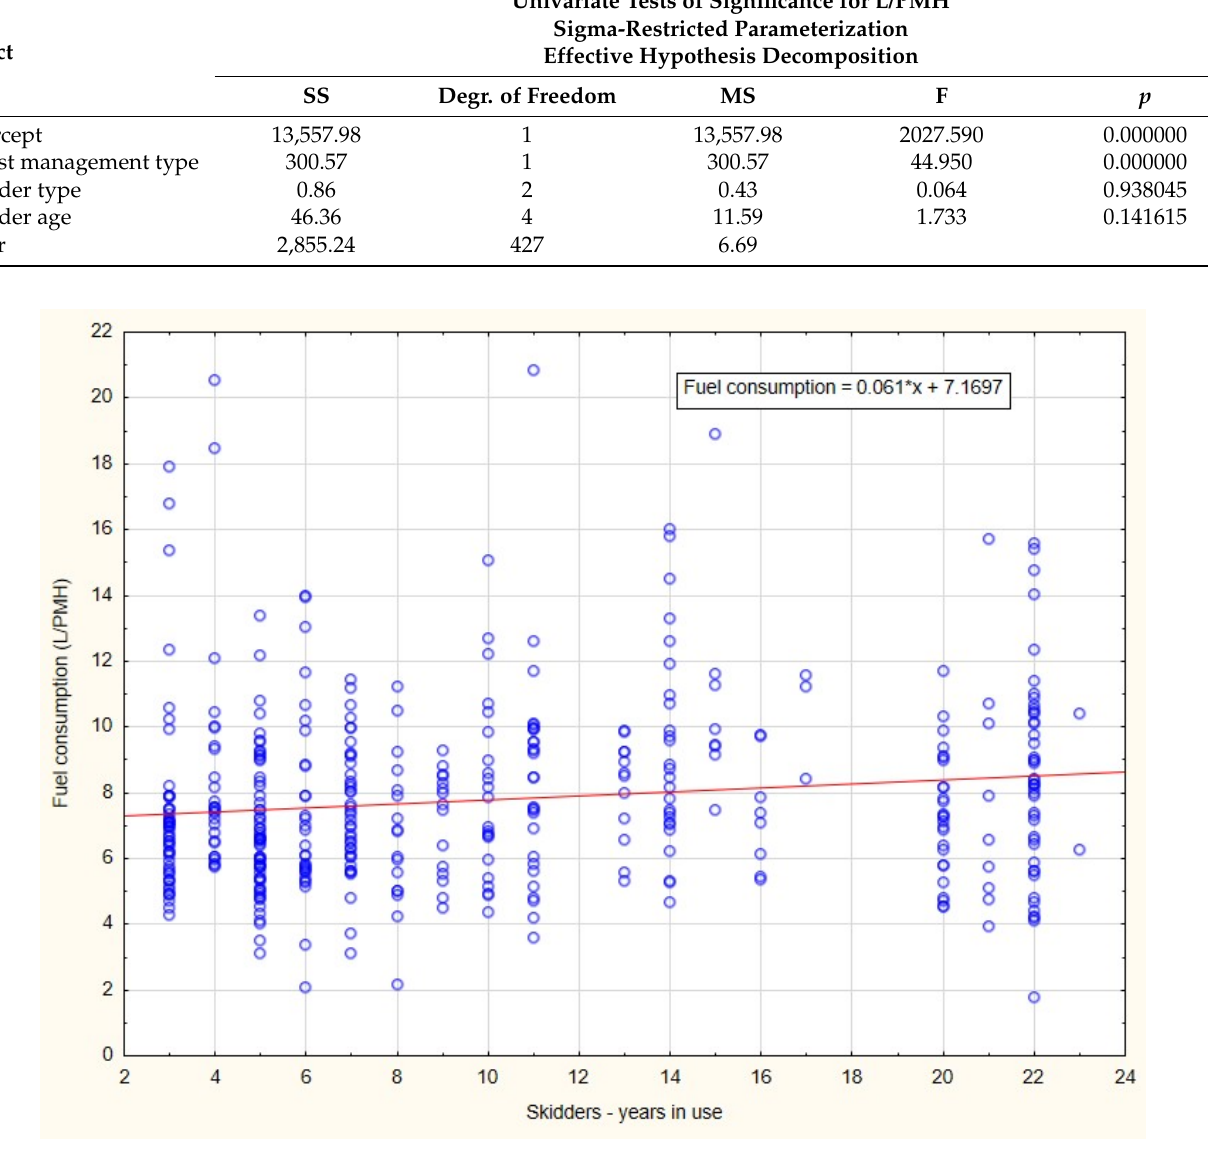
Figure 3. Skidder fuel consumption depending on years in